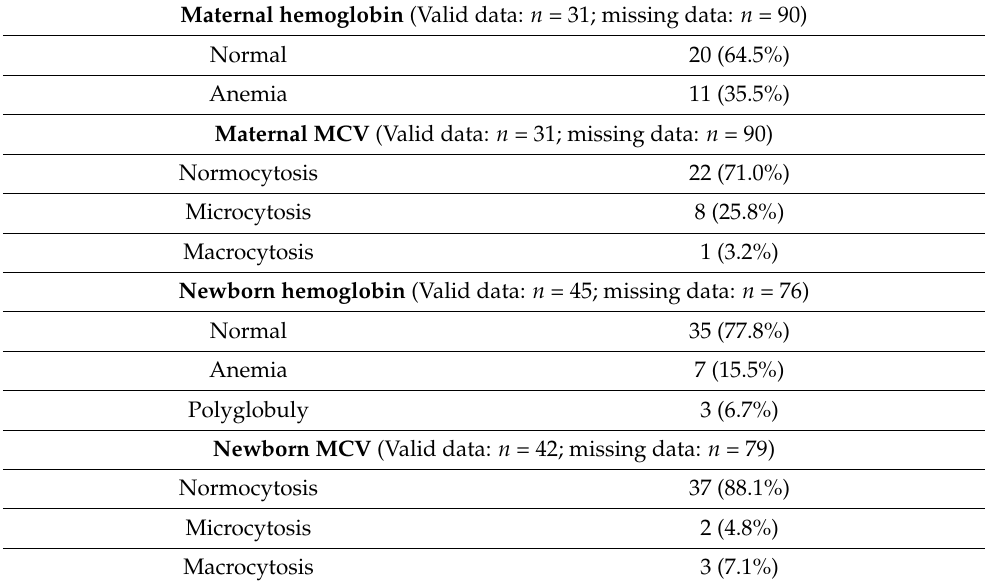
Table 2. Blood counts of mothers and